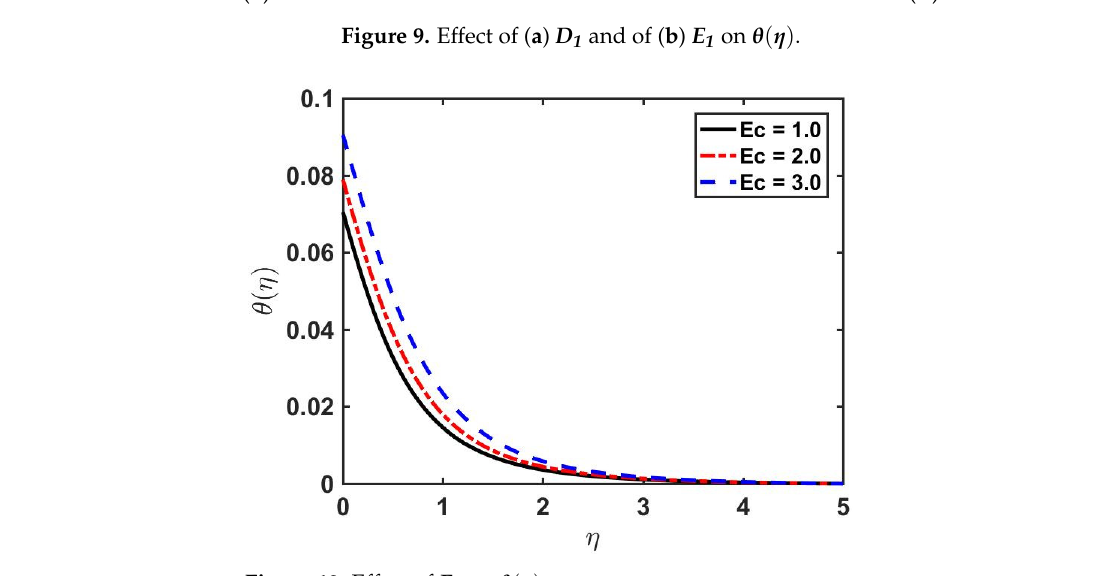
Figure 11. Effect of 𝝐 on 𝜽(𝜼) .